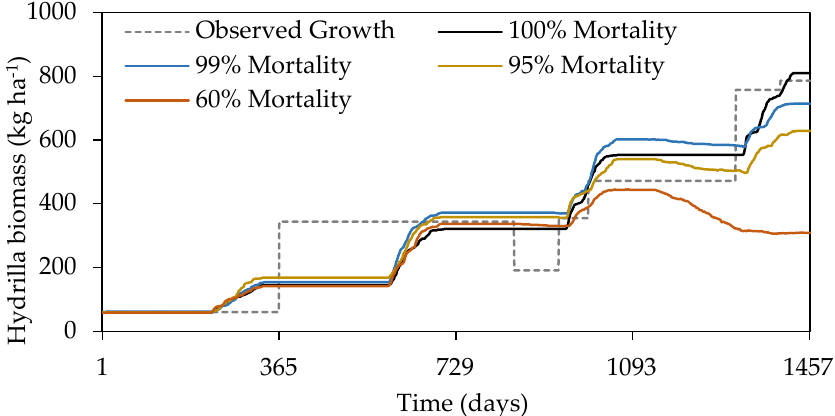
Figure 6. Comparison of simulated biomass dynamics of Hydrilla in Lake Conroe assuming the indicated annual mortality rates for grass carp.